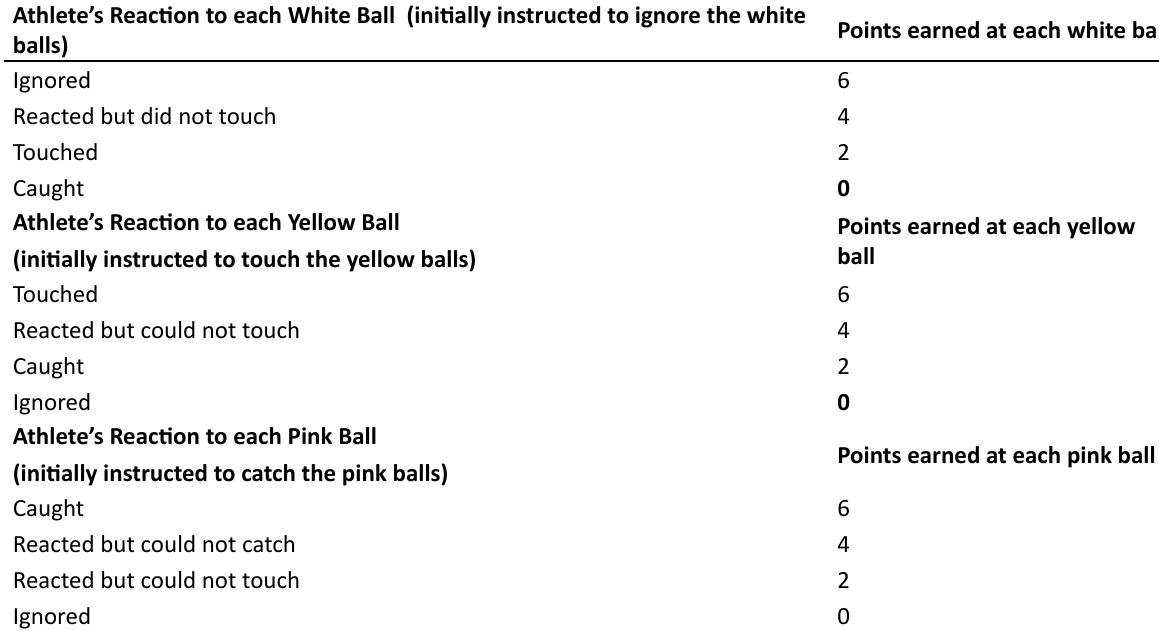
Table 1. Scoring